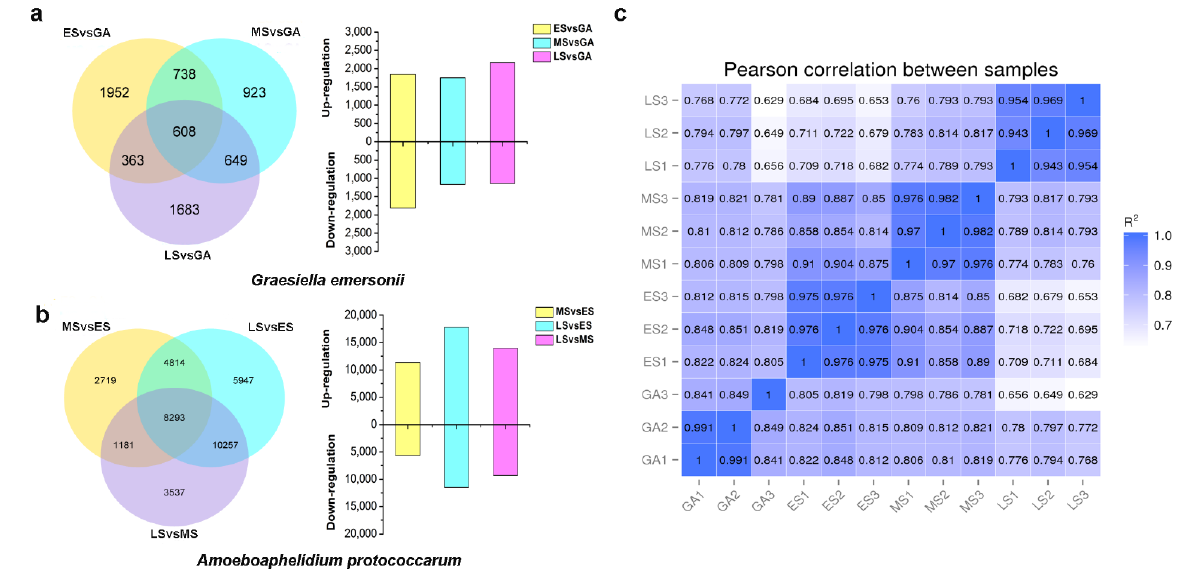
Figure 2. Global view of differentially expressed genes in G. emersonii and A. protococcarum during infection. ( a ) G. emersonii; ( b ) A. protococcarum ; ( c ) Pearson correlation coefficients of all 12 samples.